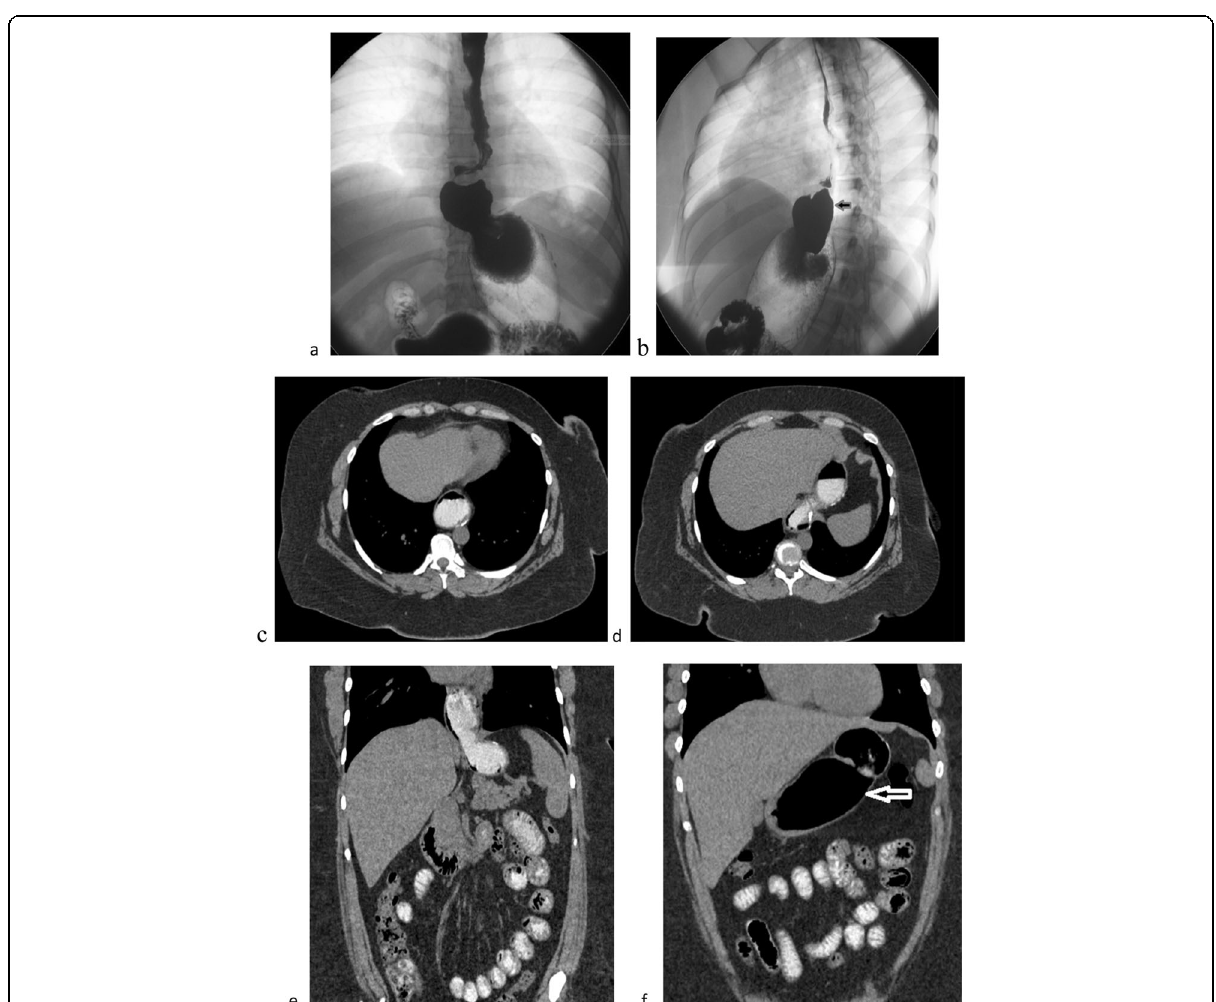
Fig. 12 A forty-year-old female patient with BMI of 56 kg/m 2 weighted 165 kg presented 3 years post-lap. sleeve gastrectomy by weight gain and heartburn. UGIS revealed increased size of the sleeved stomach and a hiatus hernia. c , d MSCT axial and e , f coronal reformatted images showed the increased size of the sleeved stomach associated with hiatus